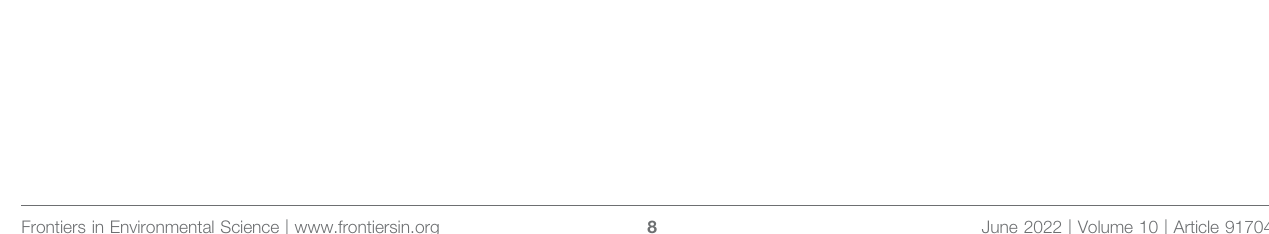
Frontiers in Environmental Science |